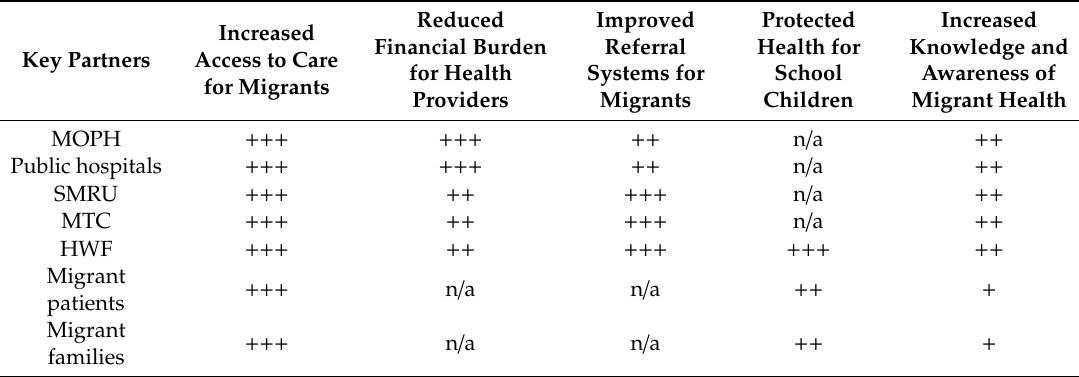
Table 4. Perspectives of stakeholders on degrees of positive impact of the